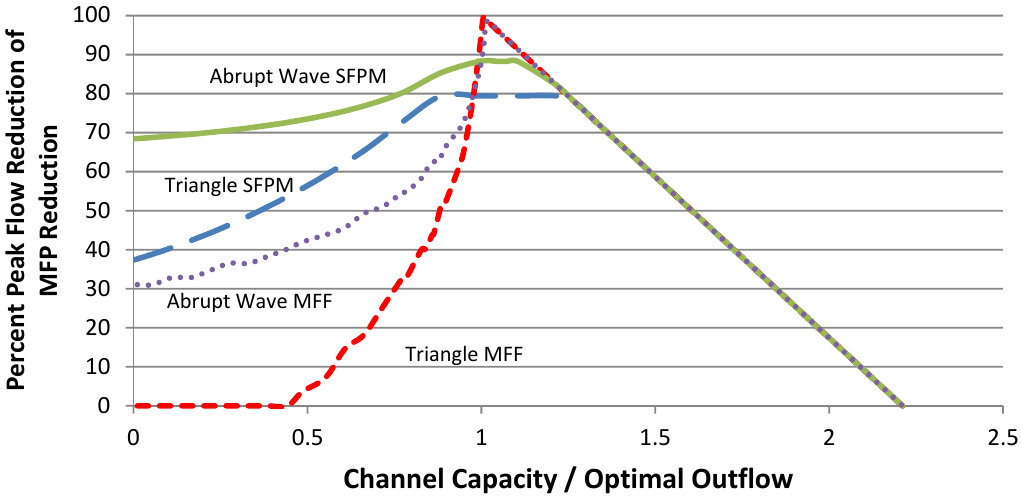
Figure 10. Comparison of minimize flood frequency (MFF) and short forecast peak minimization (SFPM) rules for triangle and abrupt wave